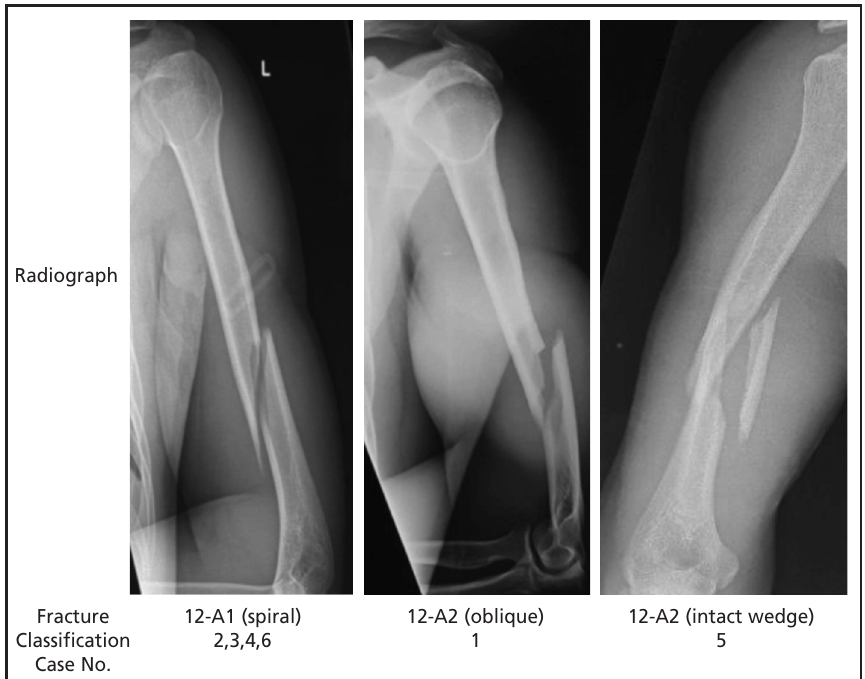
Pattern of fracture according to AOOTA Fig. 1: